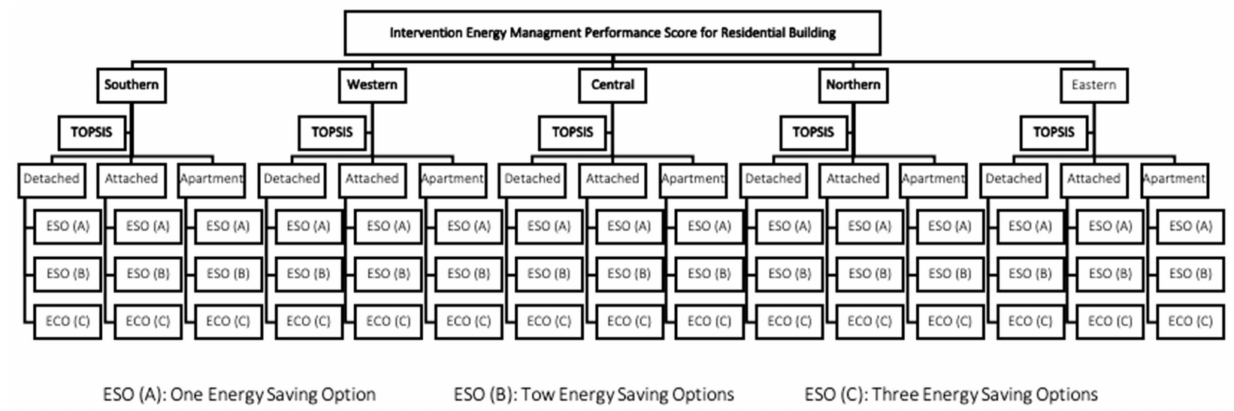
Figure 3. Evaluation of energy building interventions for residential building in Saudi